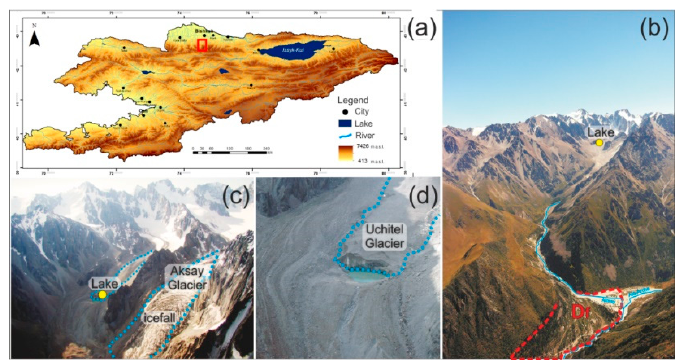
Figure 1. ( a ) Location of the Ala-Archa Valley (National Park) in Northern Tien Shan. ( b ) Oblique aerial photo overview of study site showing pro-glacial lake at the head of Aksay Valley, and the debris flow fan deposits in the low part of the Aksay Valley. ( c ) The Aksay Glacier and location of the lake adjacent to the Uchitel Glacier. ( d ) Close-up of the pro-glacial lake adjacent to the Uchitel Glacier.